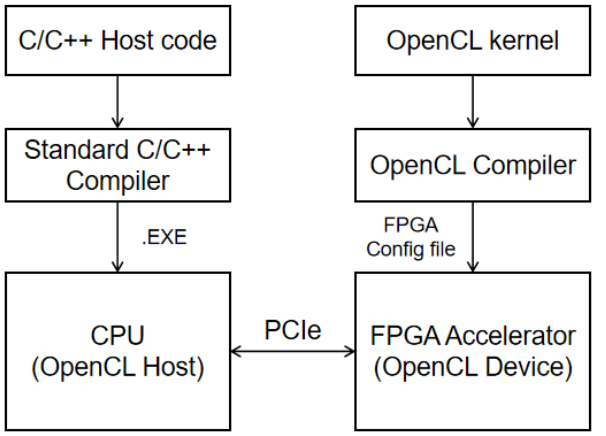
Figure 1. FPGA design flow of OpenCL-based CNN accelerator.